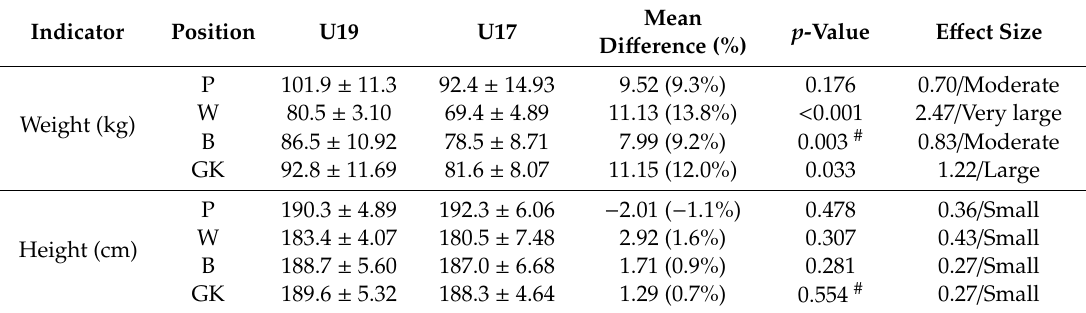
Table 1. Physical characteristics of handball players across their playing